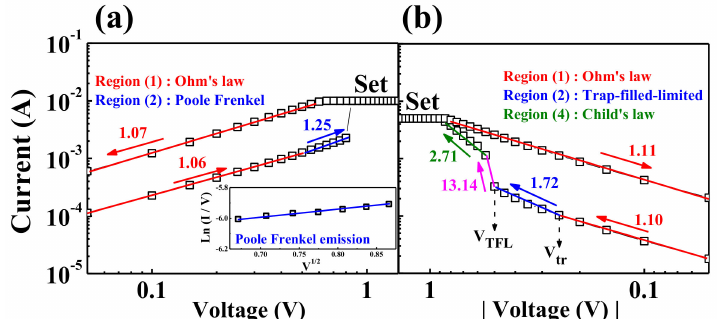
Figure 6. Current transport mechanism of the double logarithmic plot I – V curves in the set opera- tion. ( a ) Poole–Frenkel conduction mechanism of the HSQ memristor w/o the embedded SWCNT random network. Inset: fitting by the ln(I/V)–V 1/2 relationship. ( b ) Space-charge-limited conduction mechanism of the HSQ memristor w/ the embedded SWCNT random